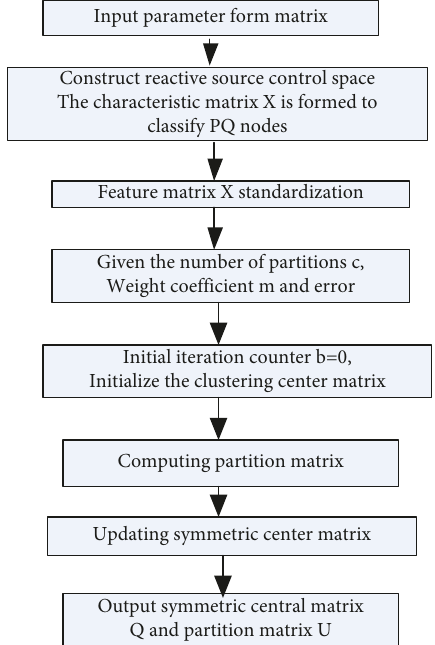
Figure 4: Flow chart of distributed control method for indoor low- voltage electrics.